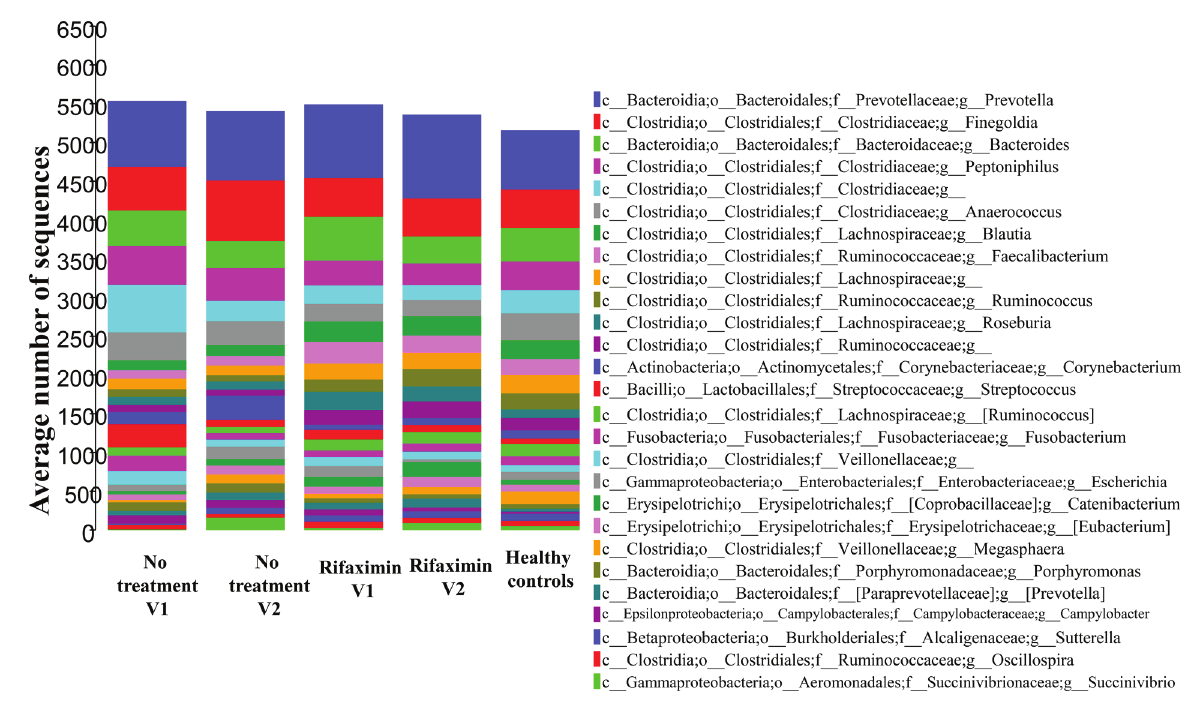
Supplemental Figure 2. Genus-level microbial community composition of fecal microbiome samples from individuals in the Rifaximin and placebo experimental arms. A set of 21 matched healthy controls (HIV-) are also shown. Average abundance of each taxon is shown among 31 individuals (Rifaximin arm) and 17 individuals (placebo). Each sample was rarefied to 6500 sequences and average values for each taxon are shown. Taxa greater than 1% of the total dataset are